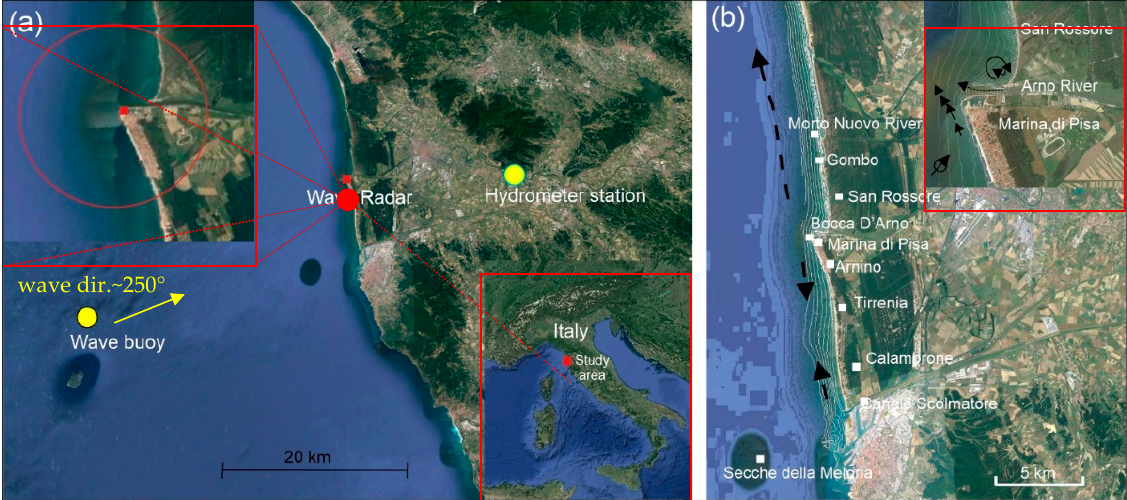
Figure 1. ( a ). The wave buoy of “ Gorgona ”, with a close arrow to indicate the dominant direction of storm waves observed during the present survey, and the hydrometer station of “ San Giovanni alla Vena ” are shown. The surveyed area is highlighted with a red circle in the frame on the upper left while the study area is reported in the frame on the lower right. ( b ). The main direction of longshore current (black arrows) and a detail at Arno mouth, in the upper right of image, are shown. At present, the Arno River delta, stretching out to sea, breaks the linearity of the coastline and favours a divergence in the seawater circulation (Figure 1b). The sediment load amounts to approximately 1524.000 t/yr [43], feeding both sides of the coast reaching the localities Calambrone southward and Gombo northward, as defined by the grain size and petrographic analysis of the sediments that form the beaches [44]. An emerging